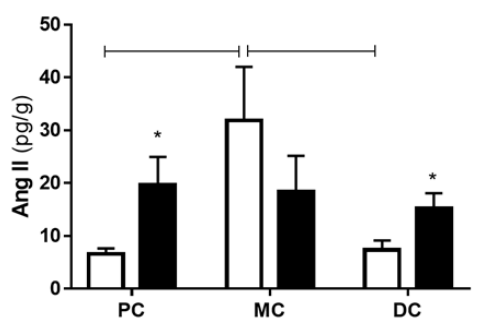
Figure 3. Levels of Ang II of control (white bars) and TNBS-induced rats (black bars) in the PC (controls: n = 5; TNBS: n = 4), the MC (controls: n = 5; TNBS: n = 5) and the DC (controls: n = 6; TNBS: n = 5). * p < 0.05 vs. corresponding control; capped lines point to statistically significant differences between groups with p < 0.05.